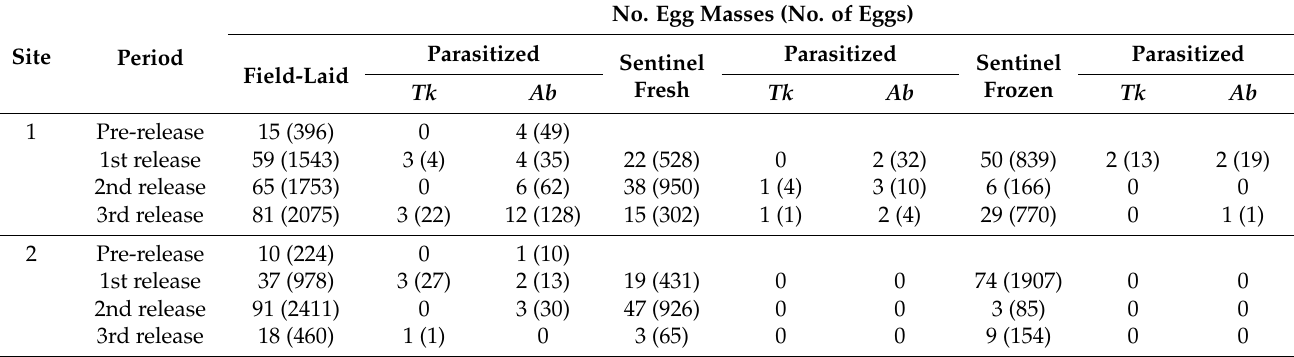
Table 5. Numbers of Halyomorpha halys egg masses (and eggs), field-laid and sentinel (fresh and frozen) egg masses, and numbers of parasitized ones by Trissolcus kozlovi ( Tk ) or Anastatus bifasciatus ( Ab ), before and after releasing T. kozlovi in two hazelnut orchards in Piedmont, North Italy, in 2018. No. Egg Masses (No. of Site Period